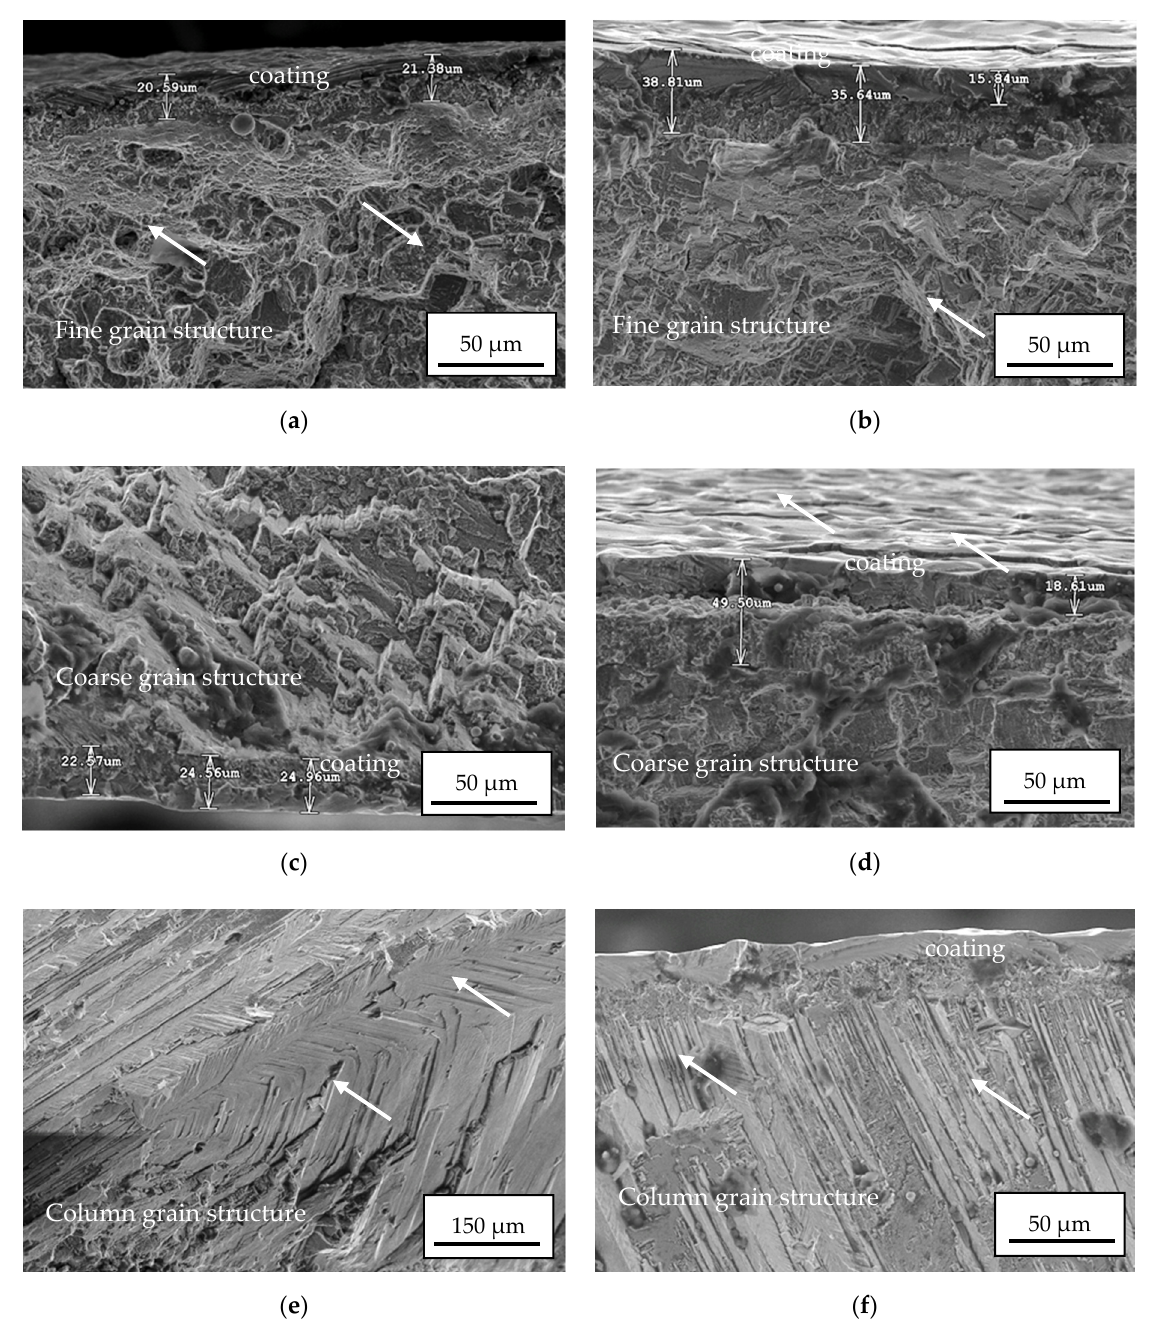
Figure 12. Fracture surfaces of the coated MAR 247 nickel-based superalloy: ( a ) fine grain/NiAl coating of 20 µm; ( b ) fine grain/NiAl coating of 40 µm; ( c ) coarse grain/NiAl coating of 20 µm; ( d ) coarse grain/NiAl coating of 40 µm; ( e ) column grain/NiAl coating of 20 µm; ( f ) column grain/NiAl coating of 40 µm observed by using scanning electron microscope.